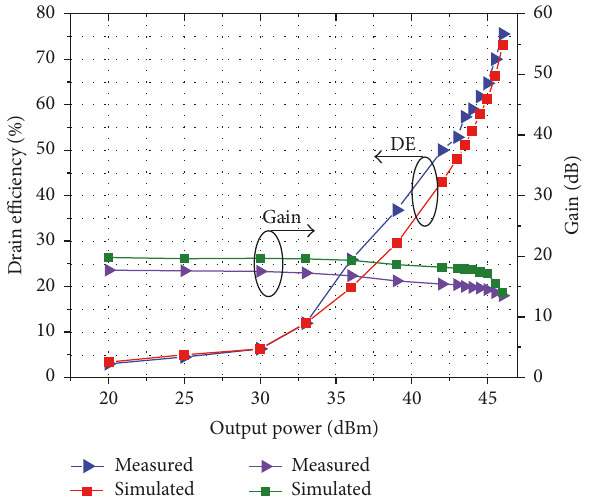
Figure 13: Comparison between measured and simulated drain efficiency and gain versus output power at 1.7GHz.